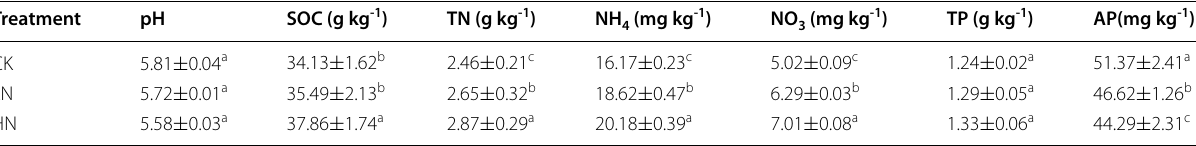
Note: Different capital letters in the same column indicate significant differences among different treatments ( P < 0.05)